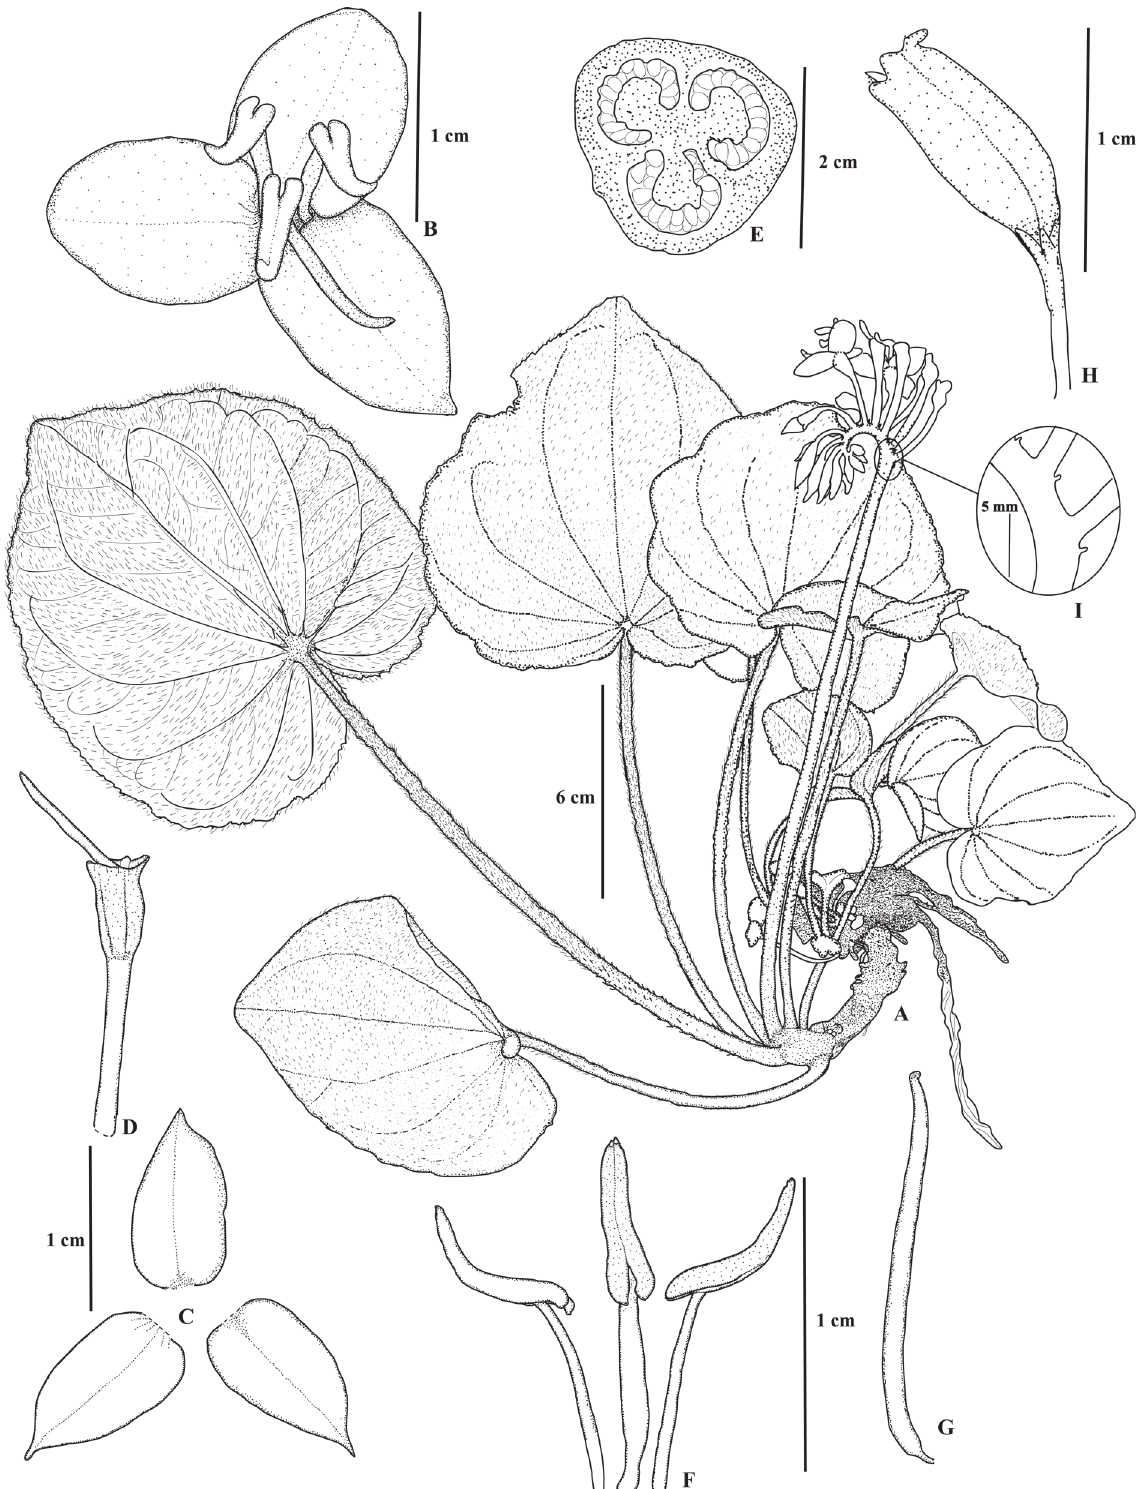
Fig. 3. Sonerila souvannii Phonep. & Soulad. sp. nov. A . Habit. B . Front view of flower. C . Petals. D . Hypanthium and style, with portion of pedicel. E . Cross section of ovary. F . Stamens. G . Style and stigma. H . Capsule. I . Rachis and minute bracts. Line drawings from holotype ( Phonepaseuth P012 ) by K.